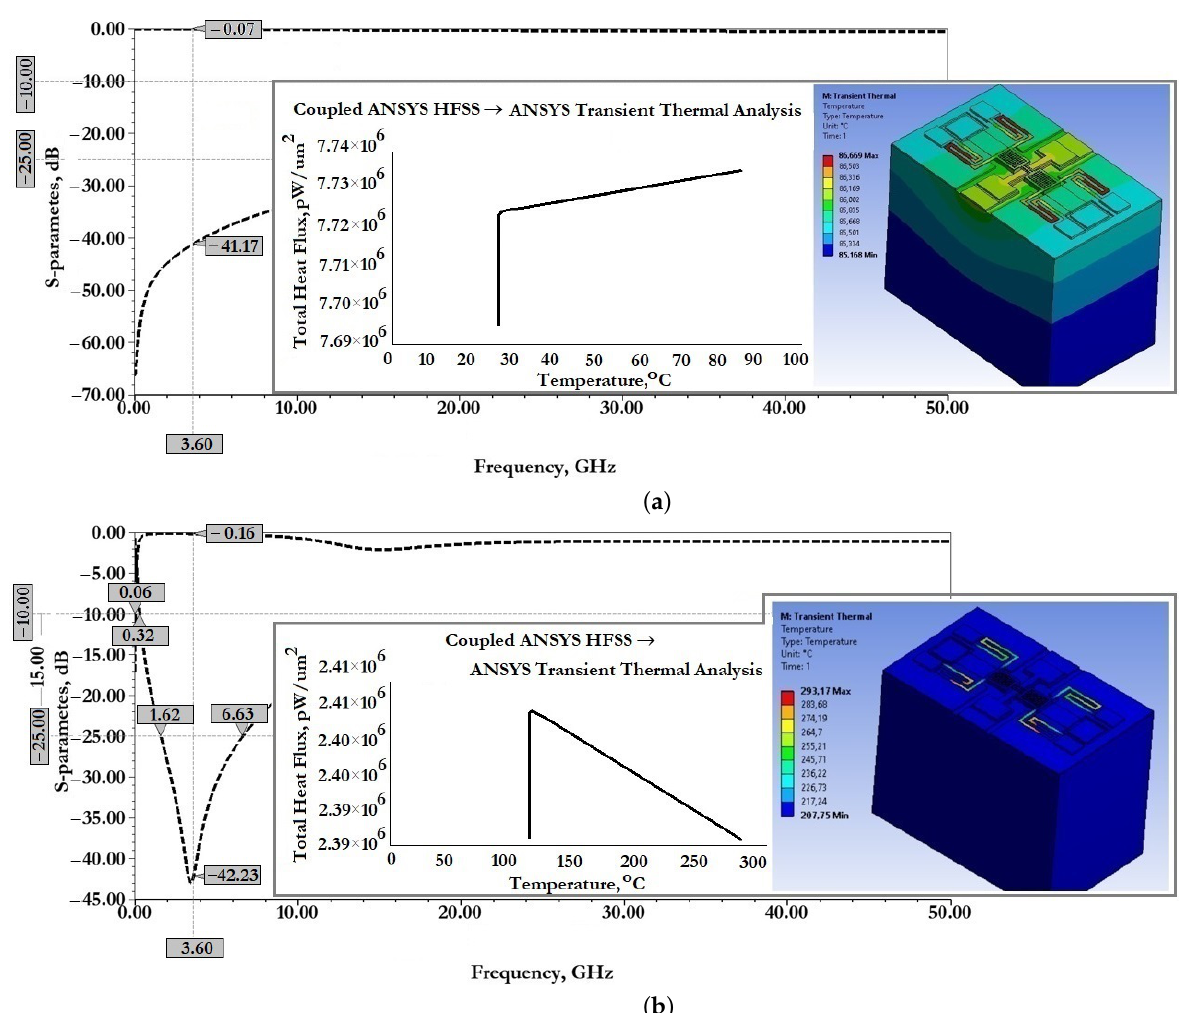
Figure 21. The results of EM and transient thermal modeling of the developed RF MEMS switch (A): ( a ) open state; ( b ) closed